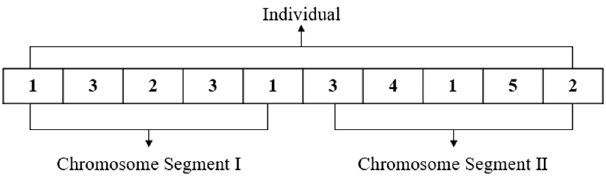
Figure 3. An example of encoding method of assistant task.